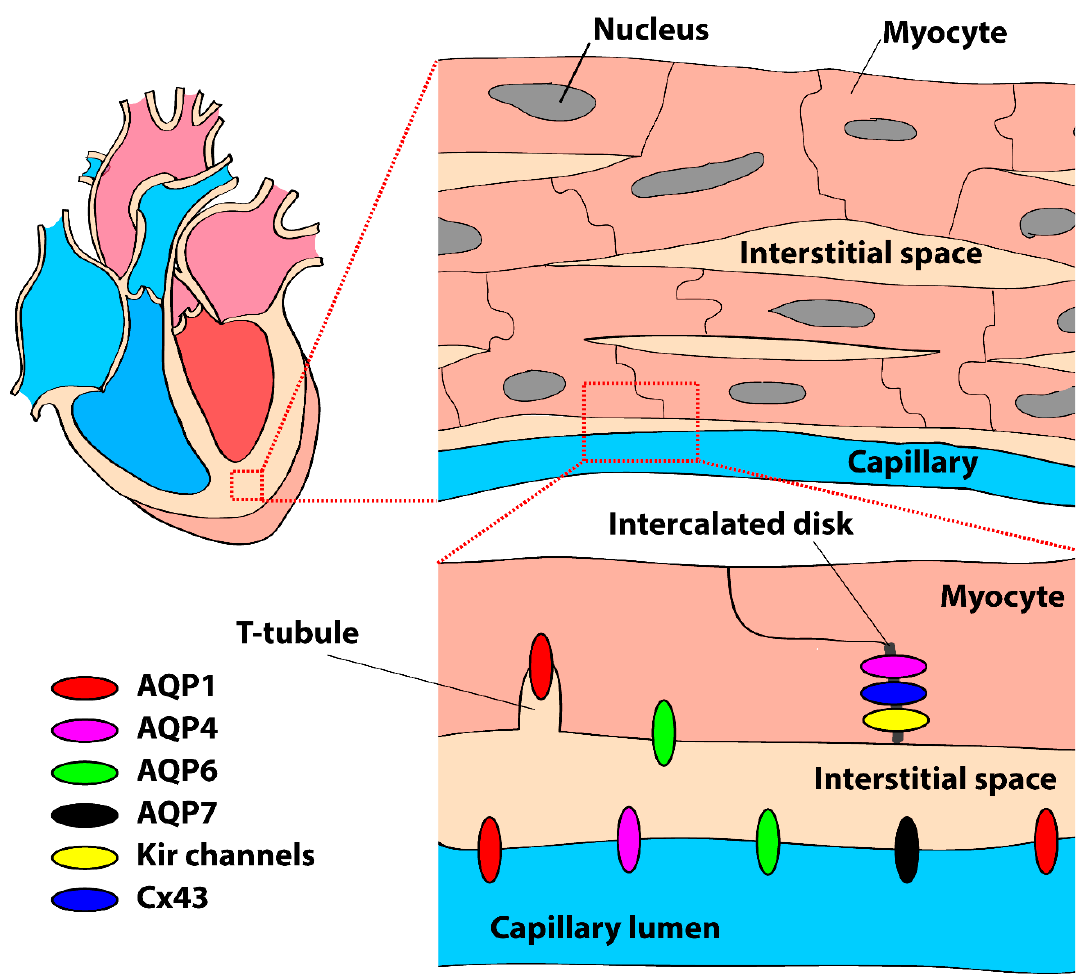
Figure 2. Schematic drawing of the presence and localization of aquaporins (AQPs) in the mammalian heart and cardiomyocytes, primarily based on data from mouse and rat (see body text). Kir channels = inward rectifier K + channels, Cx43 = connexin43.